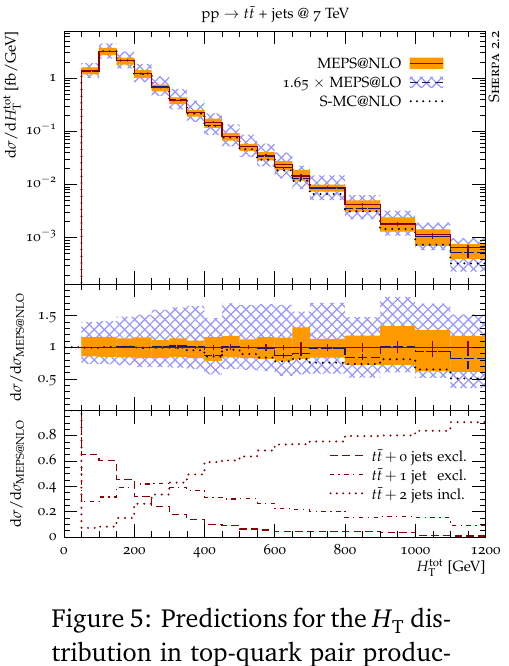
Figure 5: Predictions for the H tribution in top-quark pair produc- tion at the L HC .